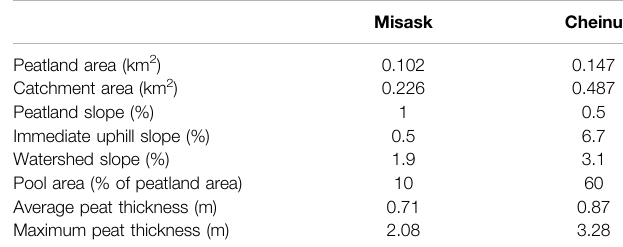
TABLE 1 | Characteristics of the Misask and Cheinu peatlands Misask